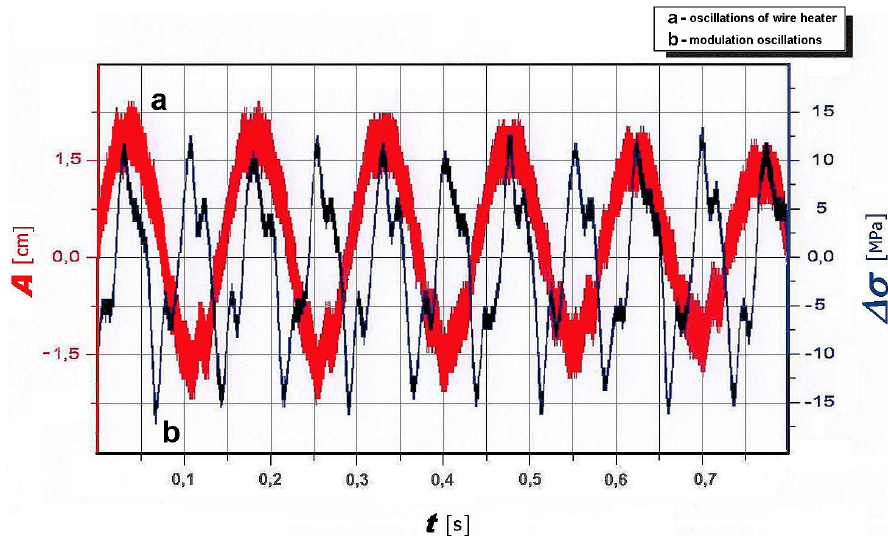
Figure 3. Typical waveform of the TMO wire heater near the first resonance ( n = 1 in Equation (3)): ( a ) transverse deflection, A, of the thin heater (red curve, ν 0 = 6.6 Hz); ( b ) pulsations of stress ∆ σ (modulation oscillation ν = 13.3 Hz, blue curve); note the beating. Here, the pre-stress of the heated wire was varied using a micrometer worm mechanism (see (2) in Figure 1) to excite the stable resonance, i.e., we did not make use of the external modulator